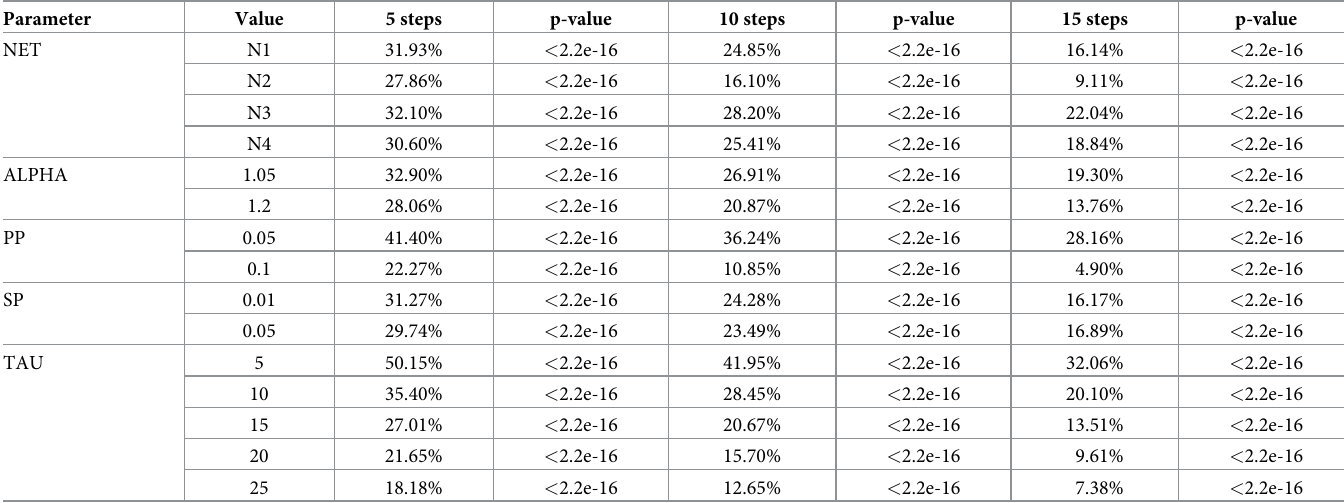
Table 5. Coverage decrease for spreading processes with the habituation effect. Parameter